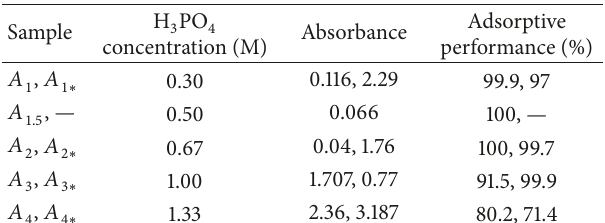
Table 6: Variation of temperature with activated carbon yield for tall tree